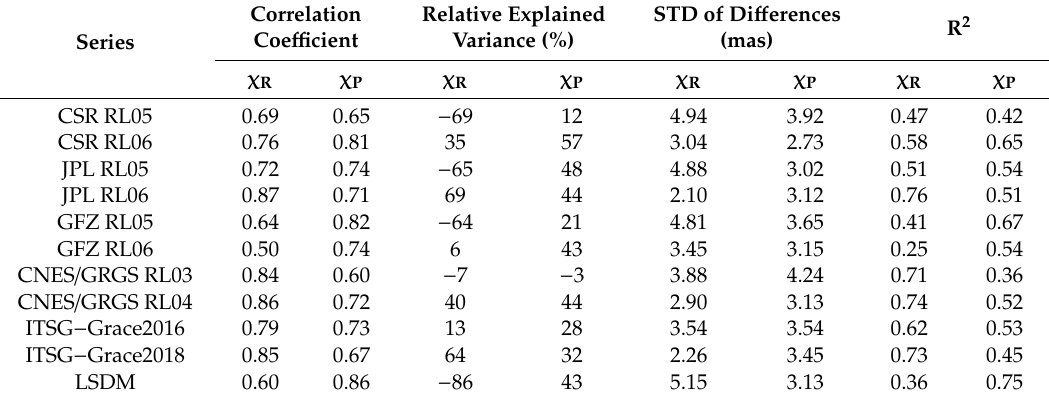
Table A5. Correlation coe ffi cients of χ R and χ P parts of long-term ( > 730 days) non-seasonal variation between GAO and HAM computed from GRACE solutions and LSDM model, the percentage of variance in GAO explained by HAM functions, standard deviation (STD) of di ff erences between GAO and HAM, and coe ffi cient of determination (R 2 ). The critical value of the correlation coe ffi cient for 25 independent points and a confidence level of 0.95 was 0.34. The standard error of the di ff erence between two correlation coe ffi cients for 25 independent points was 0.30.